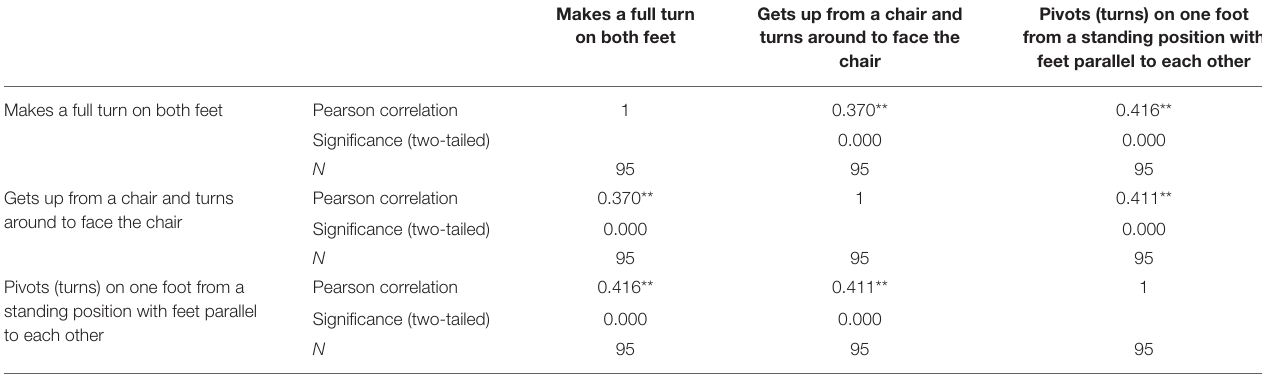
TABLE 6 | Significant correlations between specific motor skills involving stability skills.